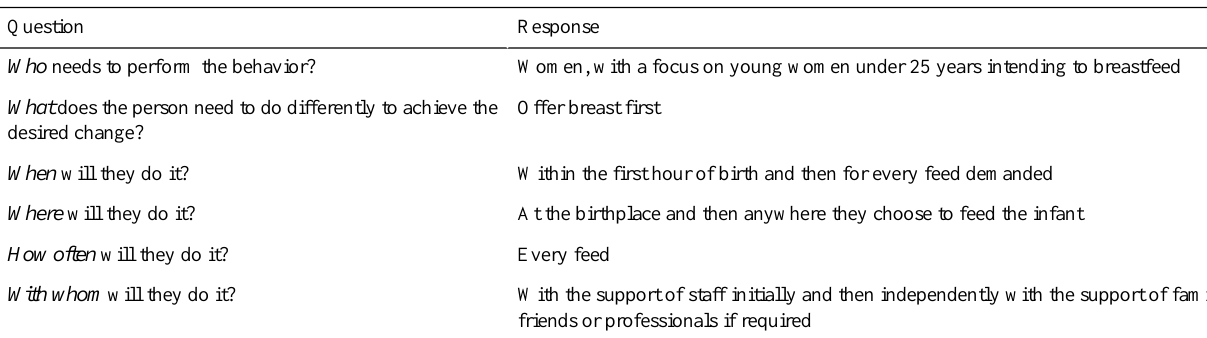
Table 1. Specifying breastfeeding as a target behavior